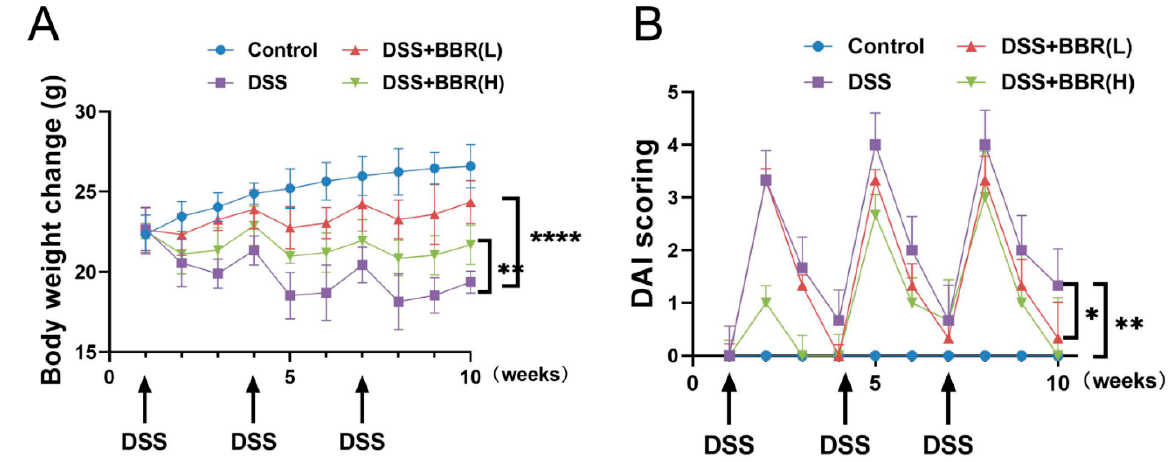
Figure 2. Effects of berberine (BBR) on clinical signs in dextran sulfate sodium salt (DSS)-induced colitis mice. Body weight ( A ) and disease activity index score ( B ) were evaluated weekly at the same time throughout the experimental period ( n = 10). Data are presented as mean ± SEM of the indicated number of independent experiments. “*” p < 0.05, “**” p < 0.01, “****” p < 0.0001 vs. model group (DSS group).